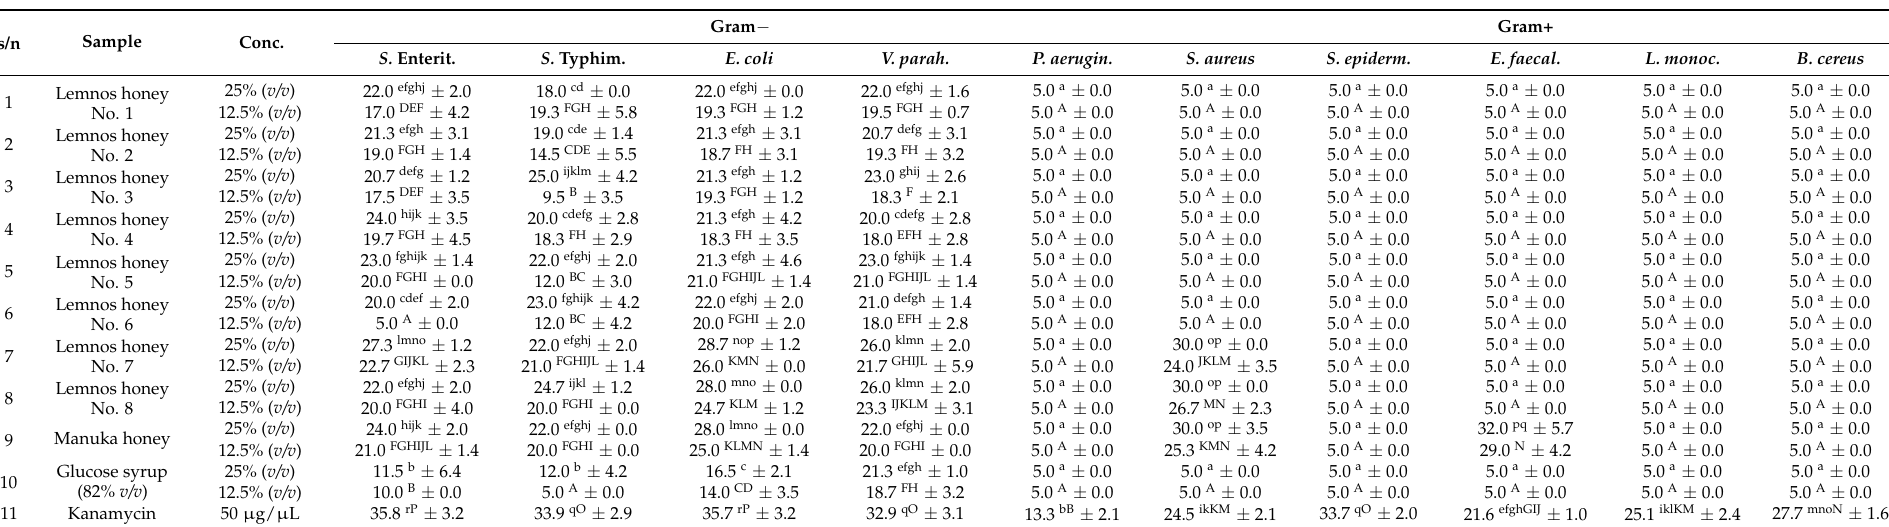
Table 1. Diameters (mm) of inhibition zones of honeys, each applied at two concentrations (25% and 12.5% v/v ) against the target bacteria, as determined by the agar well diffusion assay. Each value represents the mean value ± standard deviation ( n = 3) and comprises the diameter of the well (5 mm). The inhibition zones of glucose syrup and kanamycin used as negative and positive antimicrobial controls are also indicated. For each separate concentration, mean values sharing at least one common superscript letter are not significantly different ( p > 0.05). Lower- and capital-case letters are used for the concentrations 25% and 12.5% ( v/v ), respectively. Kanamycin was tested in a sole concentration (50 µ g/ µ L) and its inhibition zones were compared in parallel to each of the two concentrations of all the other samples (nine honey samples plus the glucose